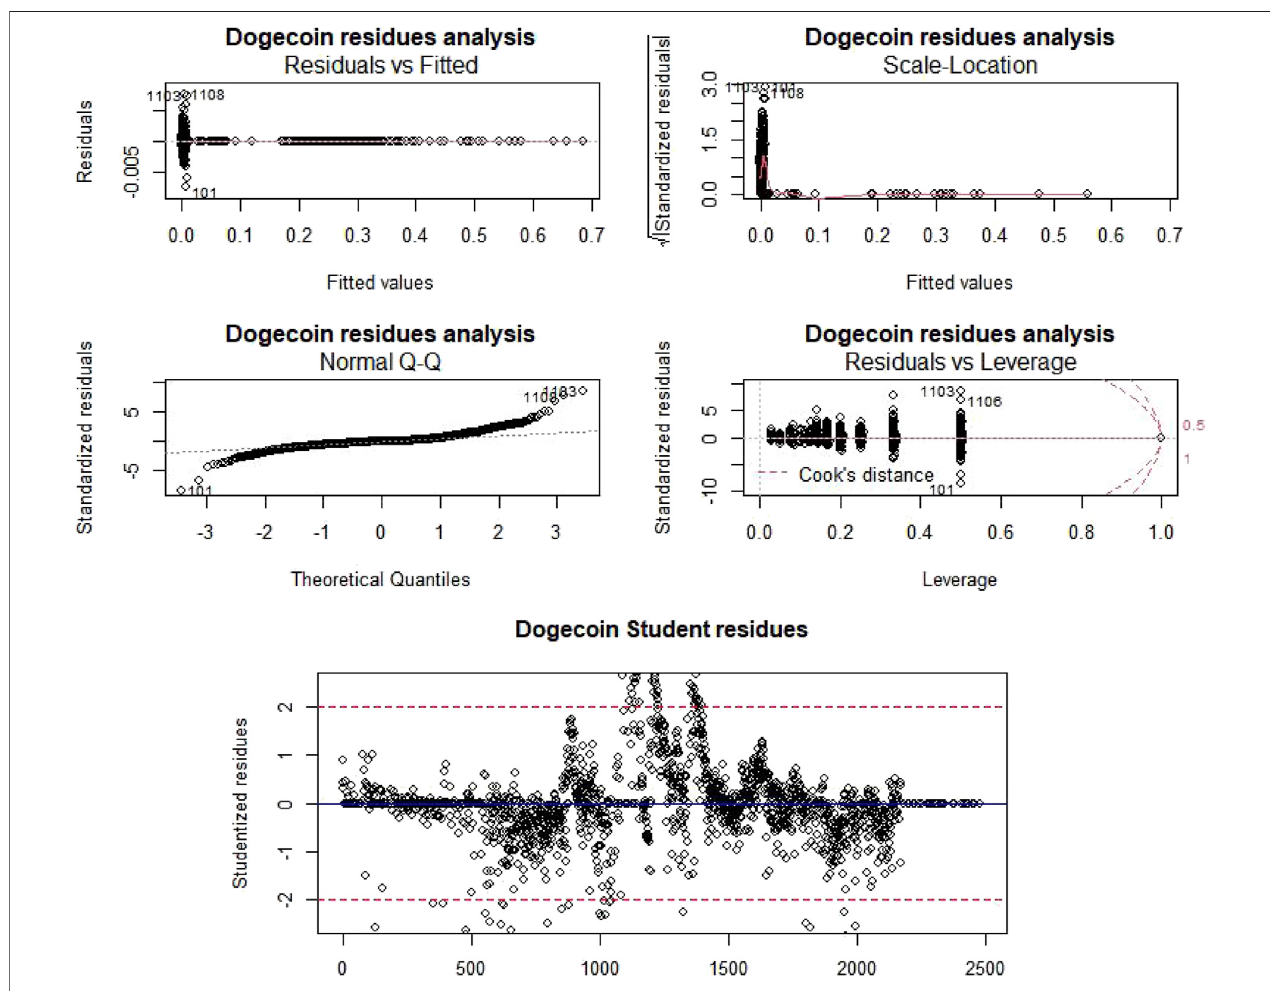
FIGURE 7 | Dogecoin residue analysis and outlier